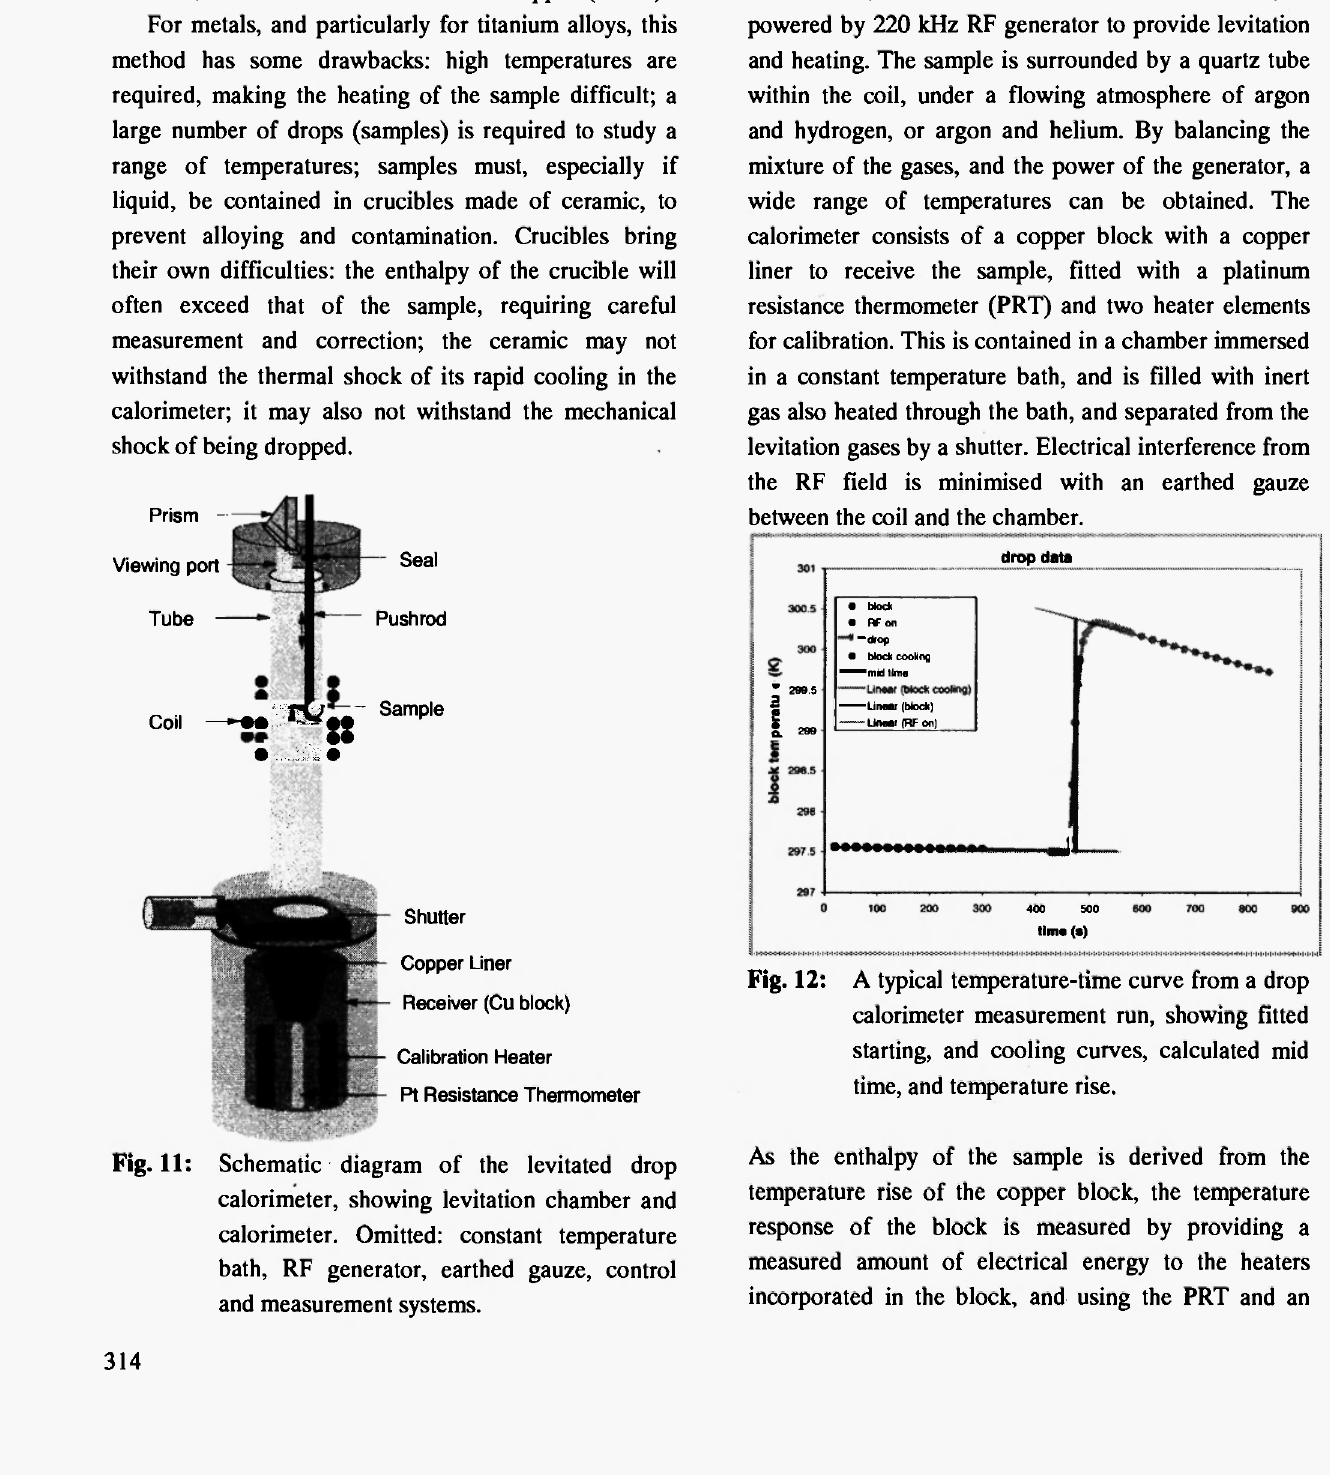
Schematic diagram of the levitated drop calorimeter, showing levitation chamber and calorimeter. Omitted: constant temperature bath, RF generator, earthed gauze, control and measurement systems.